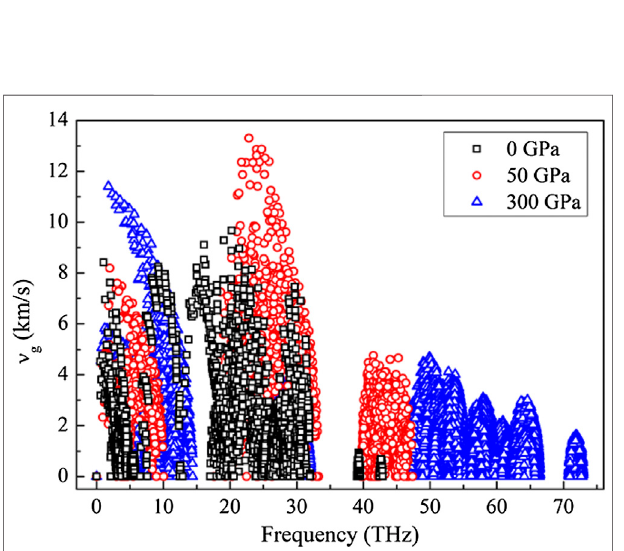
FIGURE 4 | Temperature dependent lattice thermal conductivity of YH 3 under different pressures. The dashed lines indicate the κ ∼ T − 1 dependence.